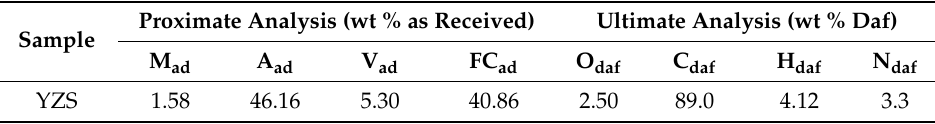
Table 7. The proximate and ultimate analysis of YZS coal